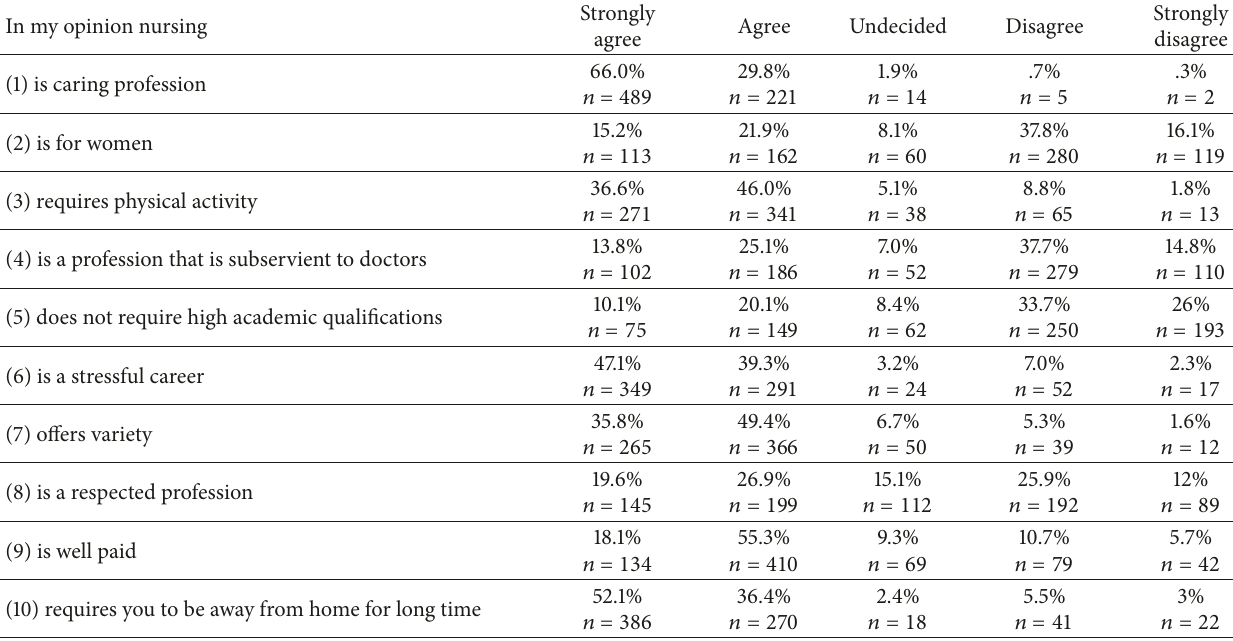
Table 4: Perceptions of nursing as a profession.